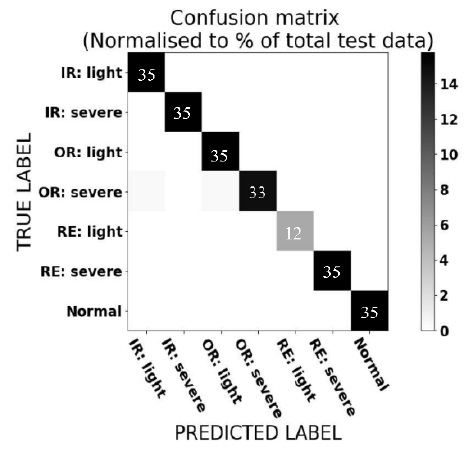
Figure 6. Confusion matrix for the training process after 2000 iterations.